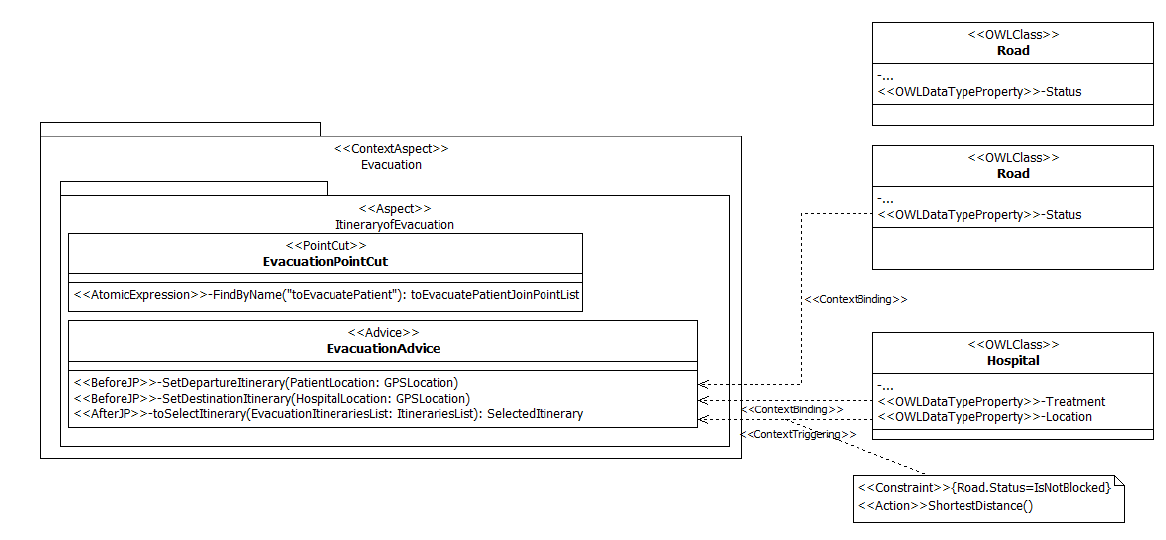
Figure 3 . Evacuation ContextAspect Model